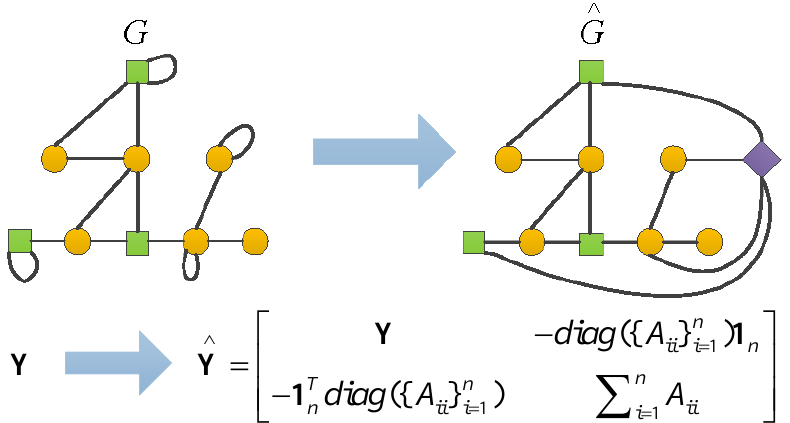
Figure 4. Changes after introducing additional grounded node (diamond icon) to a network with 4 boundary nodes (square icon), 6 internal icons (circle